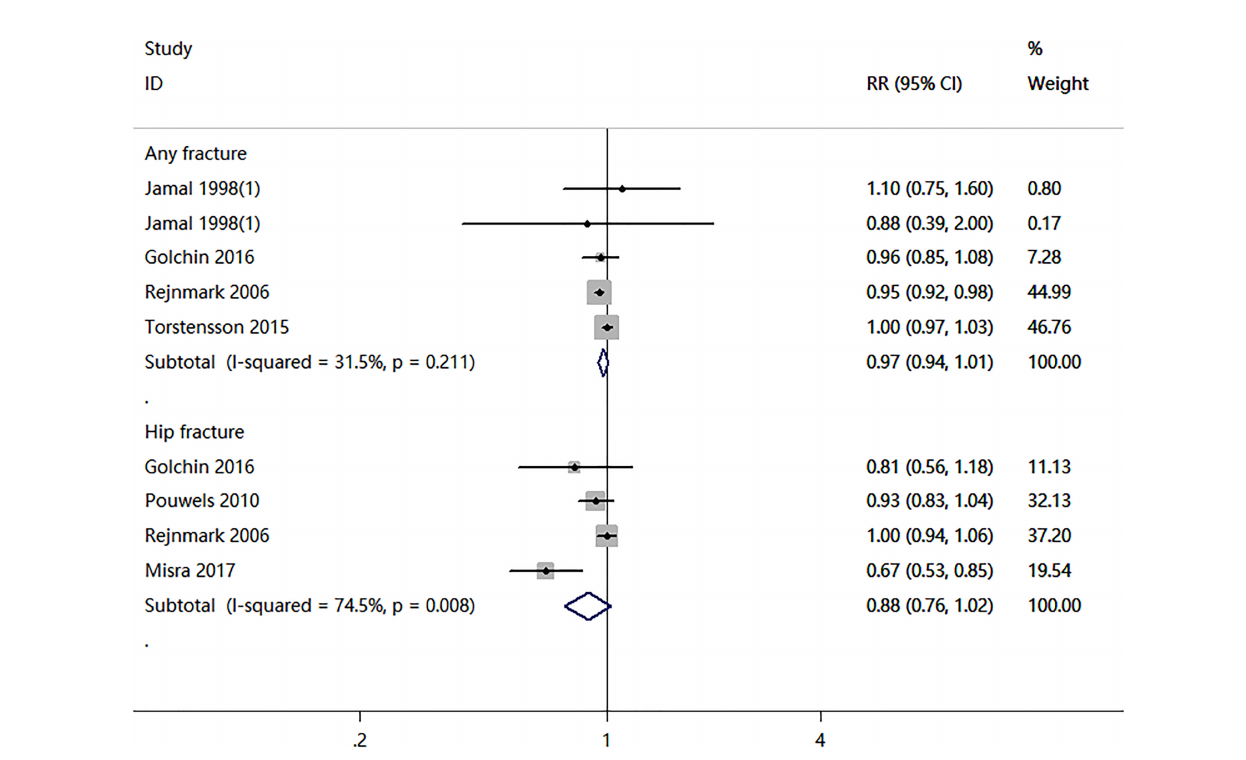
FIGURE 2 | Meta-analysis results of nitrates use for the risk of any fracture and hip